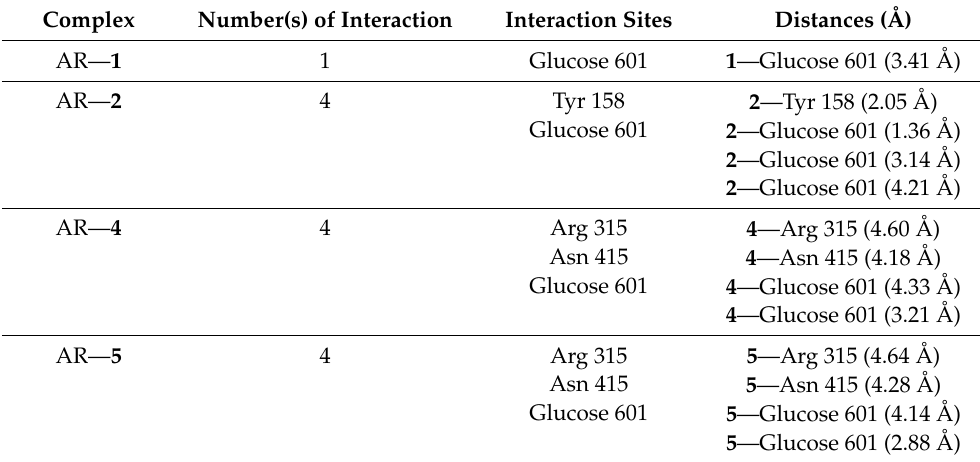
Table 2. Molecular docking interaction of the alpha-glucosidase (AR) and selected compounds. Complex Number(s) of Interaction Interaction Sites Distances